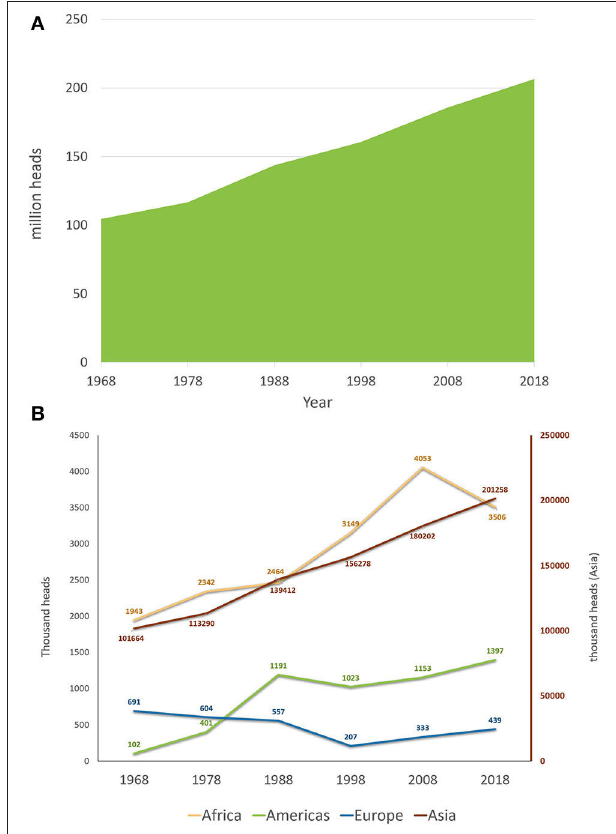
FIGURE 5 | Worldwide buffalo population trends: (A) worldwide buffalo population from the past 50 years (1968–2018); (B) worldwide buffalo population from the past 50 years (1968–2018) separated by continent. The right red axis indicates the count for Asia. America, Africa, and Europe are represented in the left axis. Source FAOSTAT (51).